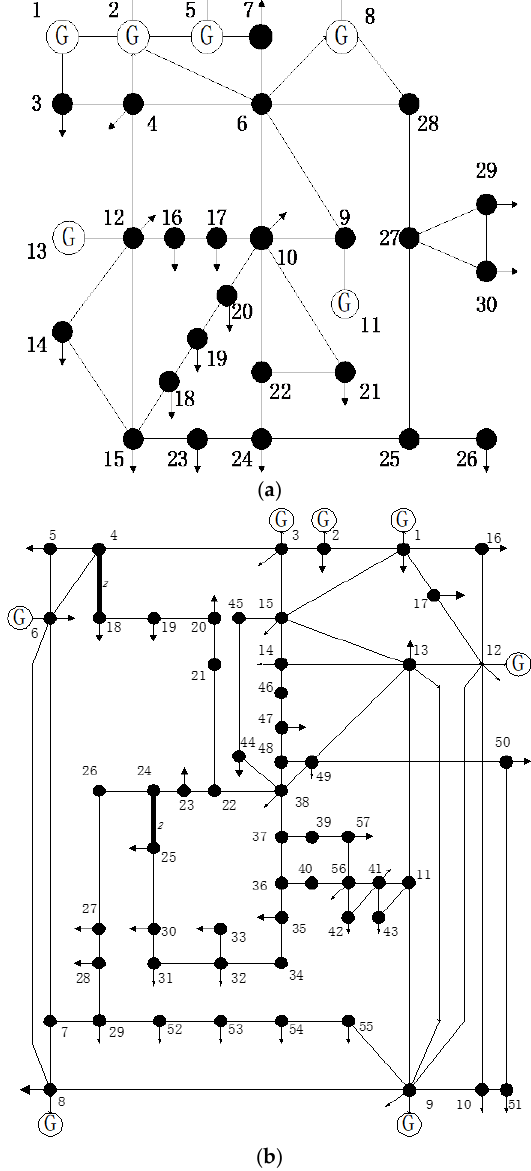
Figure A1. Topology of distribution systems. ( a ) 30-node distribution network; ( b ) 57 distribution network